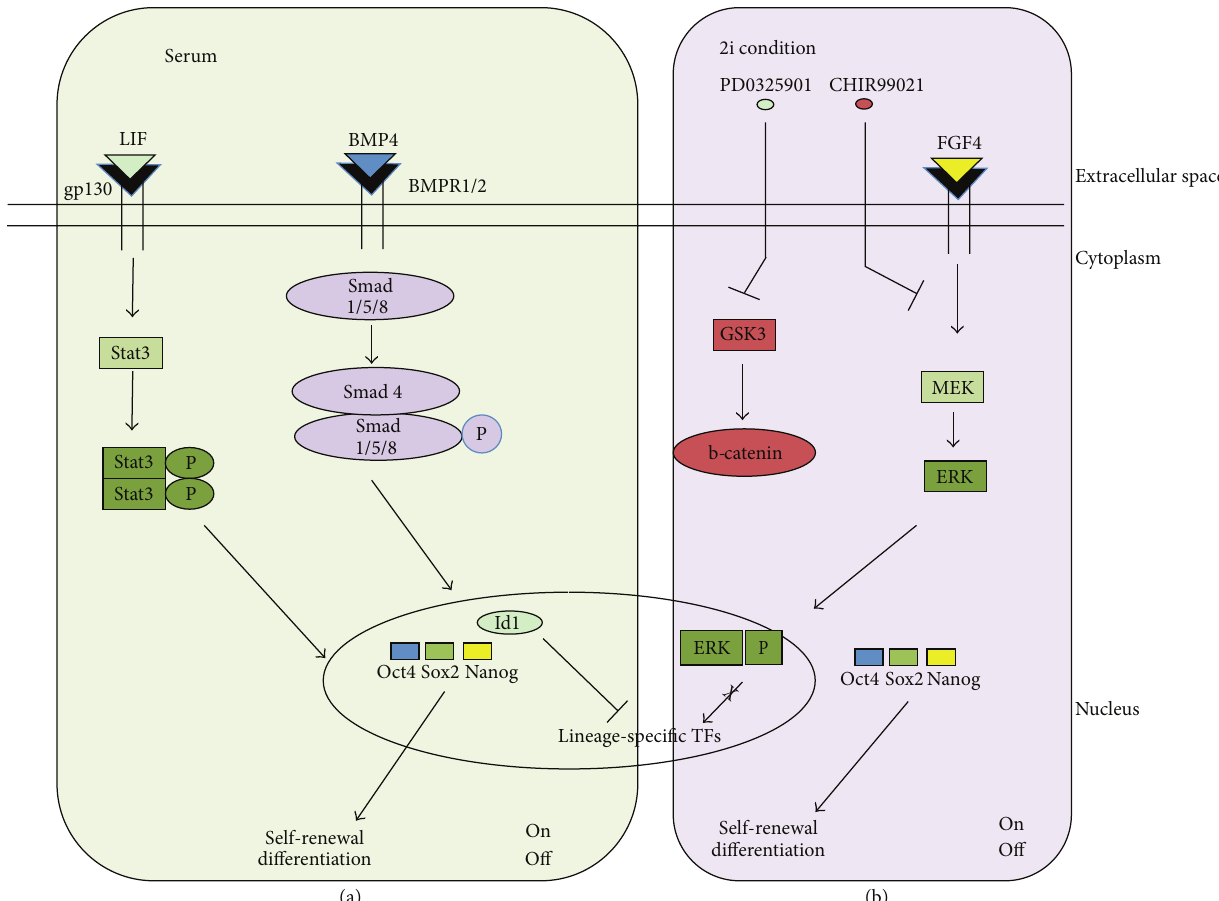
Figure 1: Signal transduction pathways in serum- and 2i-cultured